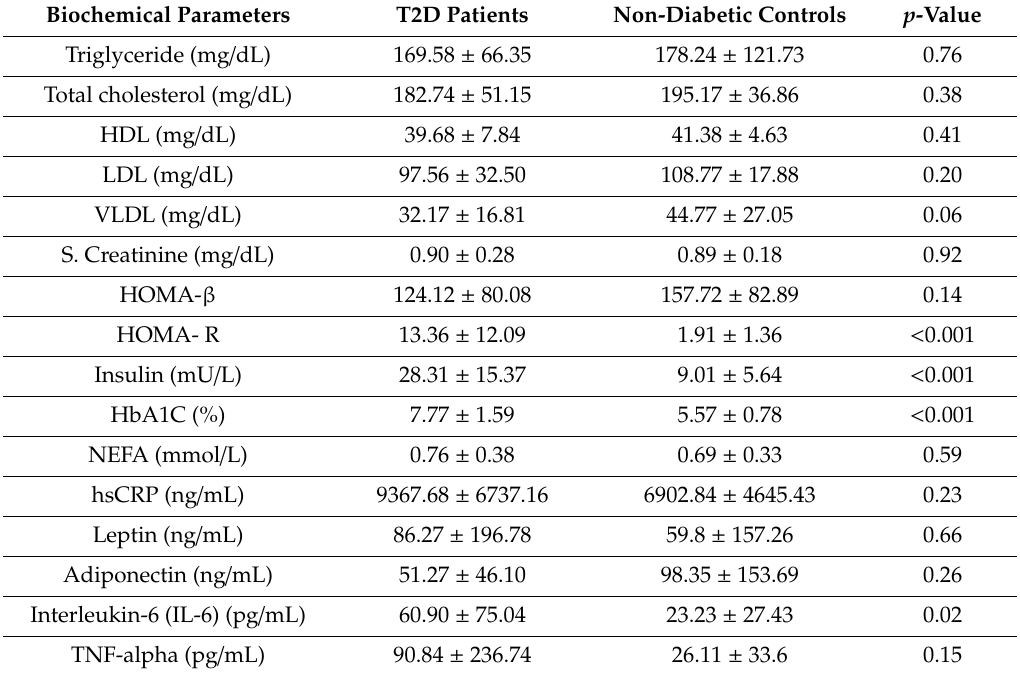
Table 3. Biochemical parameters between the two